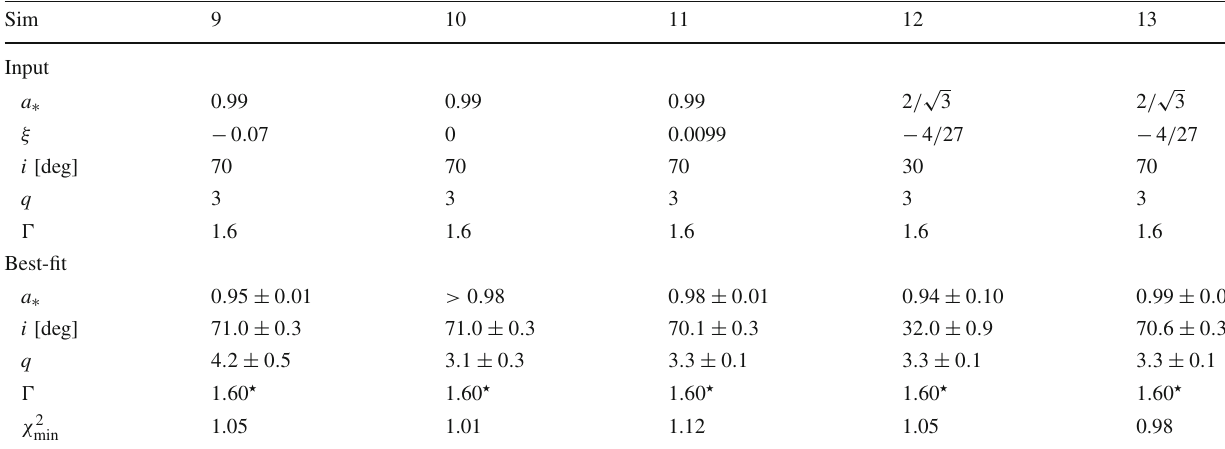
Table 2 As in Table 1 for simulations